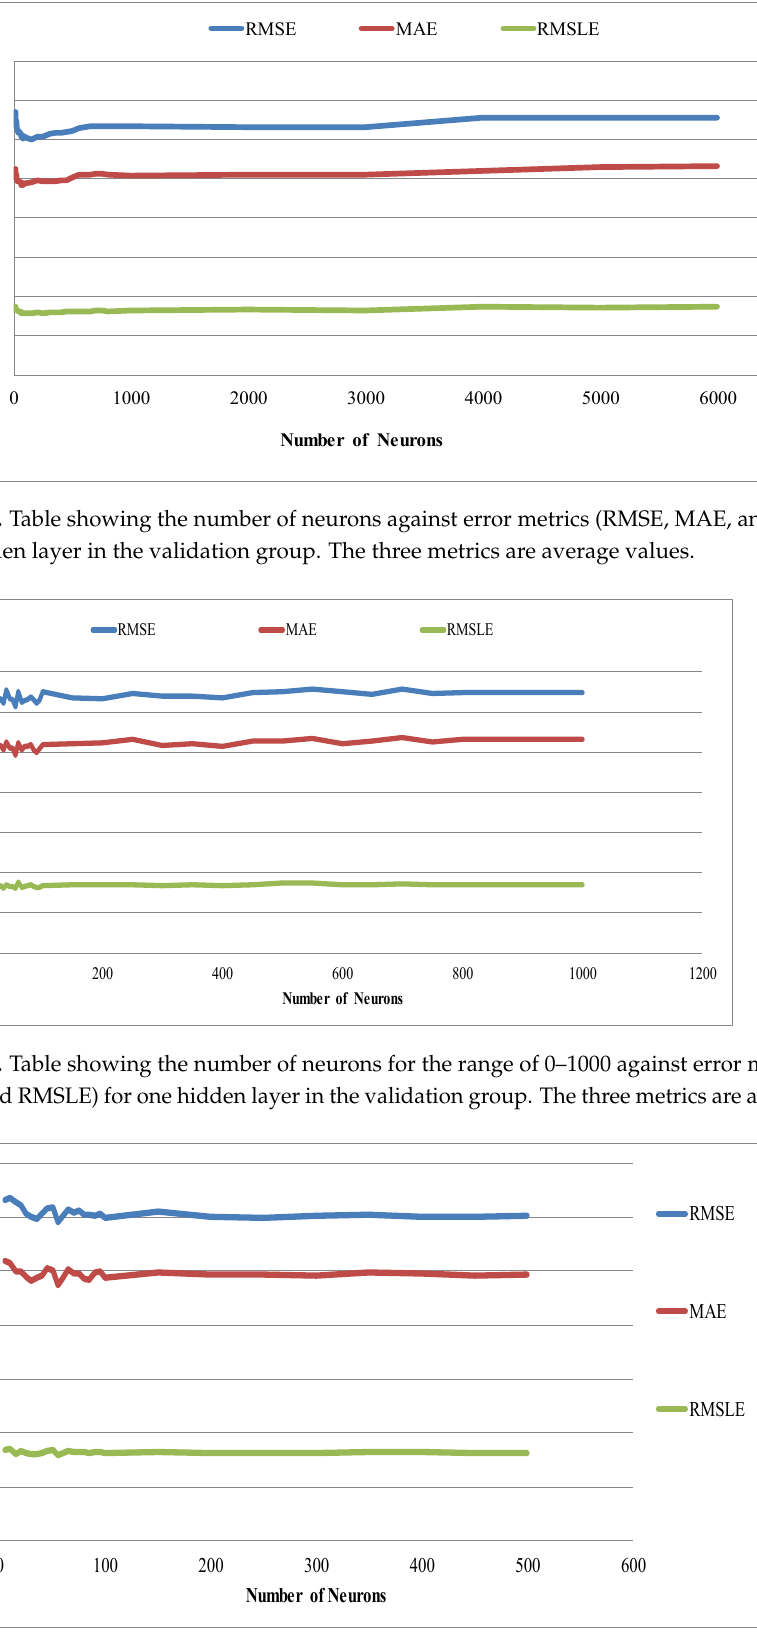
Figure 10. Table showing number of neurons against error metrics (RMSE, MAE, and RMSLE) for three numbers of hidden layers in the validation group. The three metrics are average values.